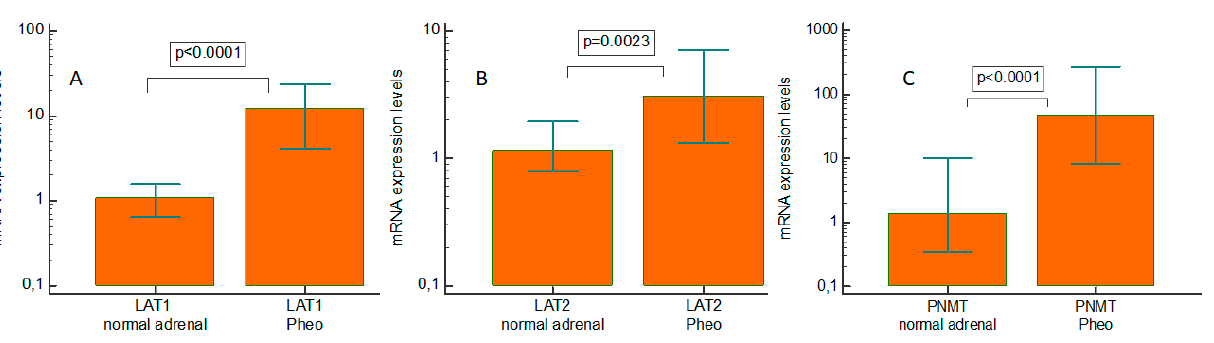
Figure 1. Real-time quantitative PCR gene expression of L-type amino acid transporter 1 (LAT1), L-type amino acid transporter 2 (LAT2), and phenylethanolamine N-methyltransferase in pheochro- mocytoma (PNMT) specimens and paired normal tissue. ( A ) LAT1; ( B ) LAT2; and ( C ) PNMT. Pheo: pheochromocytoma.